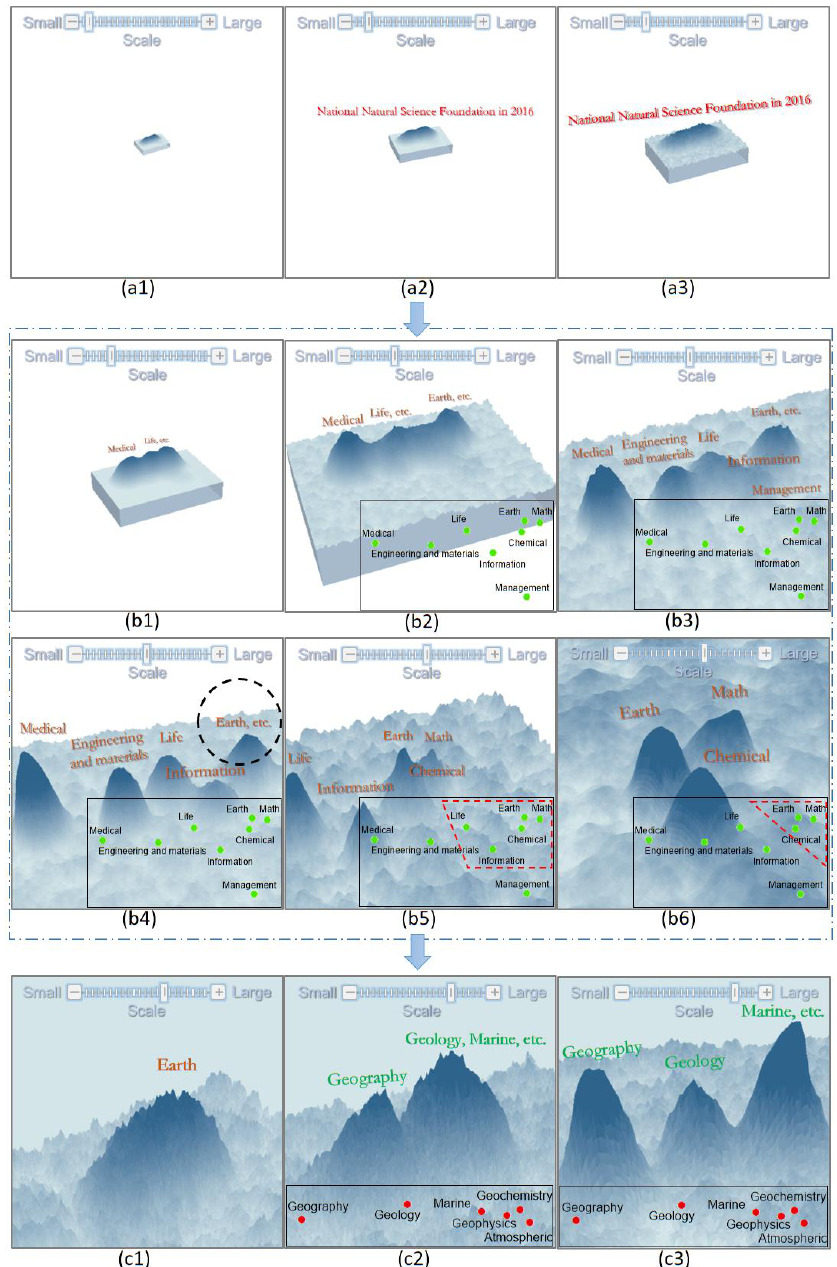
Figure 19. Multi-scale terrain reflecting hierarchical data: Group ( a ) First-level terrains; Group ( b ) Second-level terrains; Group ( c ) Terrains from the second level to the third level. Construction parameters: ( a1 ) Radius 20 m Noise 0%; ( a2 ) Radius 20 m Noise 10%; ( a3 ) Radius 20 m Noise 30%; ( b1 ) Radius 16 m Noise 0%; ( b2 ) Radius 12 m Noise 10%; ( b3 ) Radius 8 m Noise 20%; ( b4 ) Radius 6 m Noise 20%; ( b5 ) Radius 4m Noise 30%; ( b6 ) Radius 2 m Noise 30%; ( c1 ) Radius 1.5 m Noise 40%; ( c2 ) Radius 1 m Noise 40%; ( c3 ) Radius 0.5 m Noise